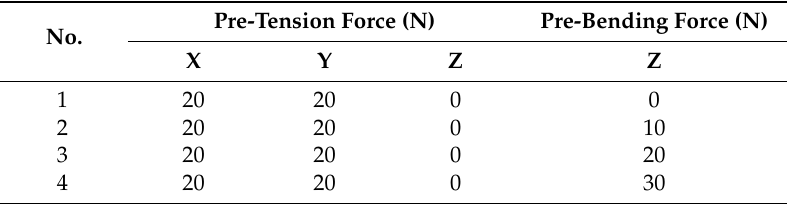
Table 2. The parameters in the biaxial tension test under different pre-bending loading. No. Pre-Tension Force (N) Pre-Bending Force (N)